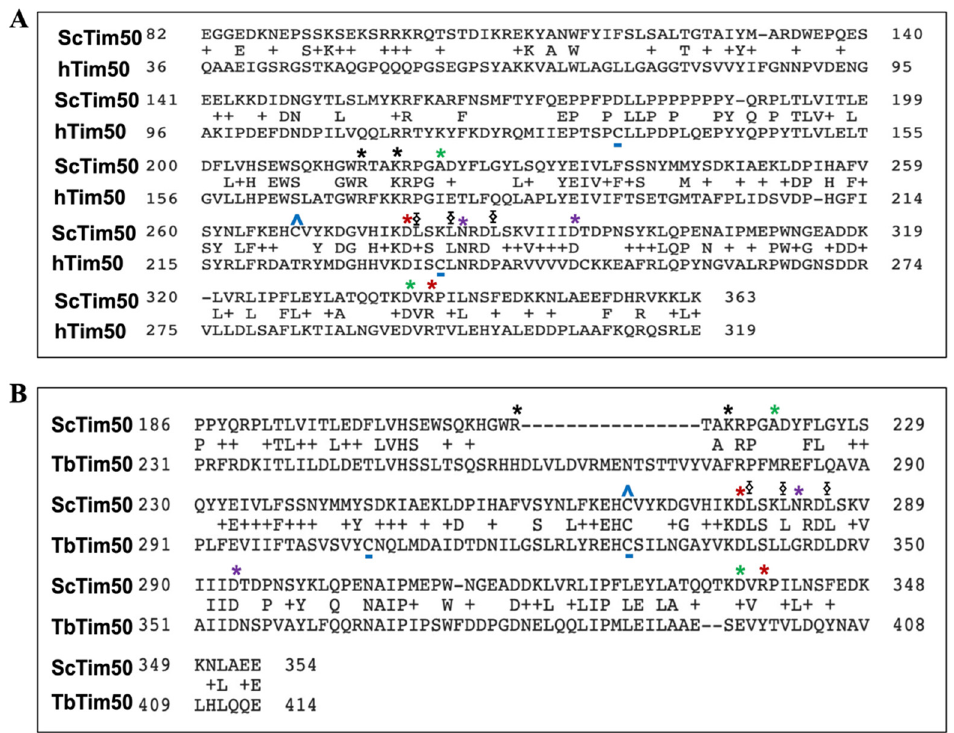
Figure 5. Primary sequence alignment of ScTim50 with hTim50 ( A ) and TbTim50 ( B ). Relatively conserved regions are shown. Identical AA residues are indicated. The conserved and non-conserved cysteine residues are indicated by blue ^ and underscore, respectively. Leucine residues within the conserved coiled-coil region (L279, L282, and L286 in ScTim50) are marked by ⧮ . AA residues R214 and K217 located on the lateral side of the β -hairpin loop that are responsible for interaction with Tim23 are indicated by *. Three AA pairs that are important for the interaction between ScTim50 and ScTim23 are shown by asterisks of different colors (*, *, and *).